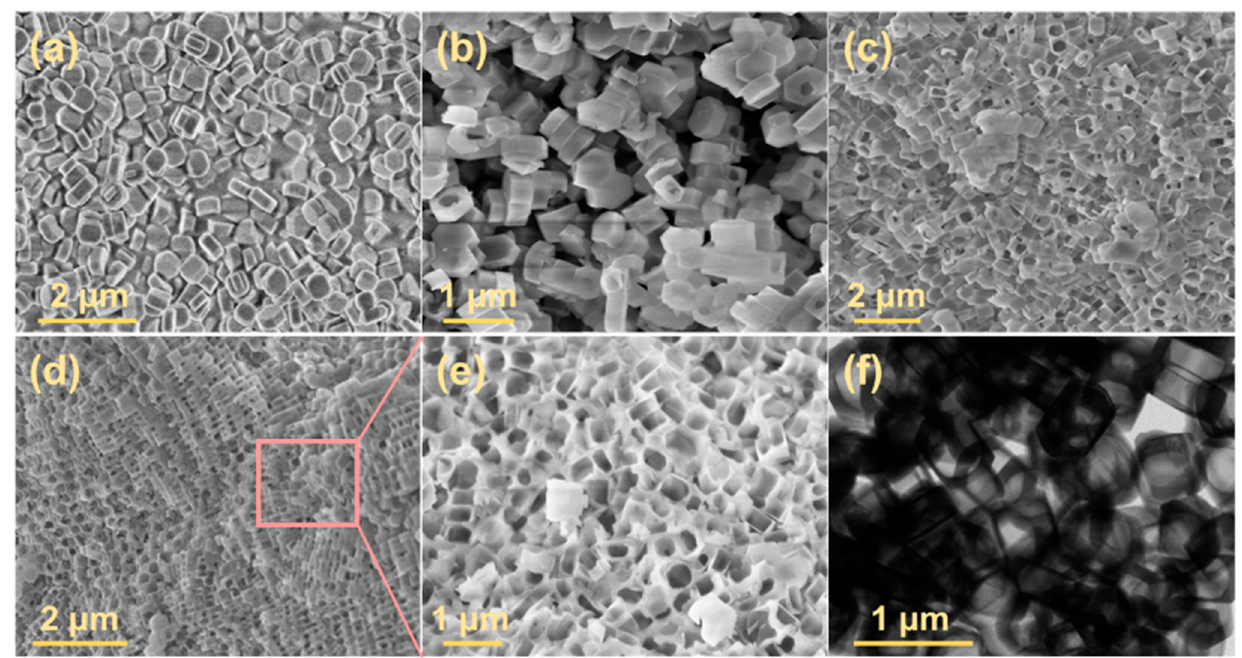
Figure 1. Scanning electron microscopy images of ( a ) S-1, ( b ) S-1 3 , ( c ) S-1 4 and ( d , e ) S-1 5 ; and ( f ) TEM image of S-1 5 .